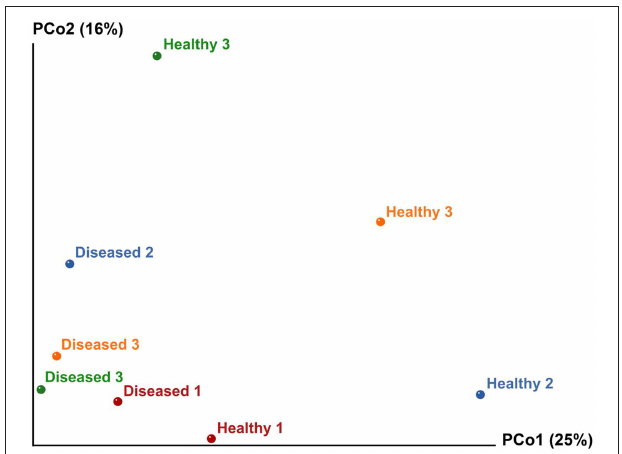
FIGURE 4 | Principal Coordinates Analysis (PCoA) of the apparently healthy tissues and diseased tissues of tumor affected P. carnosus coral based on unweighted UniFrac matrices (weighted data not shown due to similar results). Analysis showed clustering of diseased tissues from apparently healthy tissues, suggesting that the presence or absence of certain bacterial lineages may be critical for coral’s